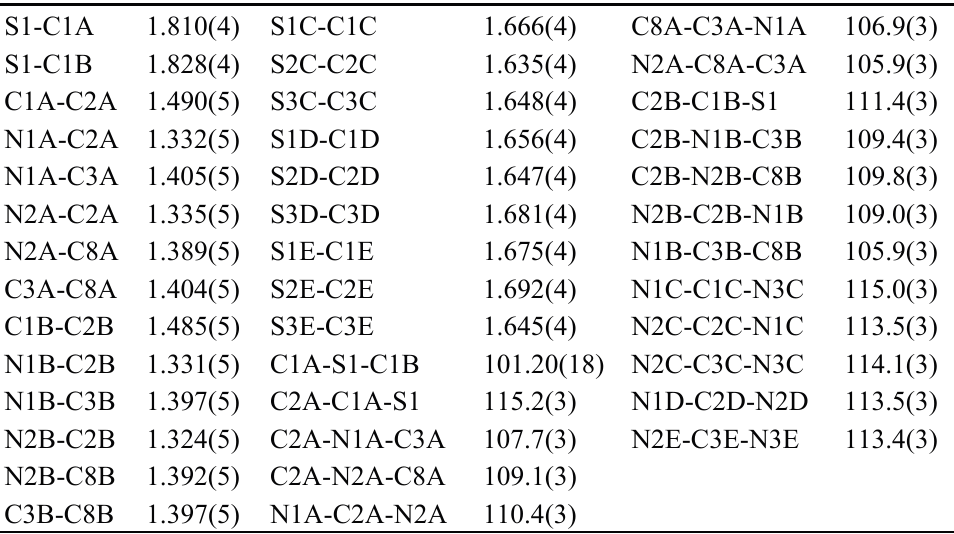
Figure 5. Projection of the contents of the unit cell along a-axis for 2 . Table 2. Selected bond lengths (Å) and angles (°) for 2